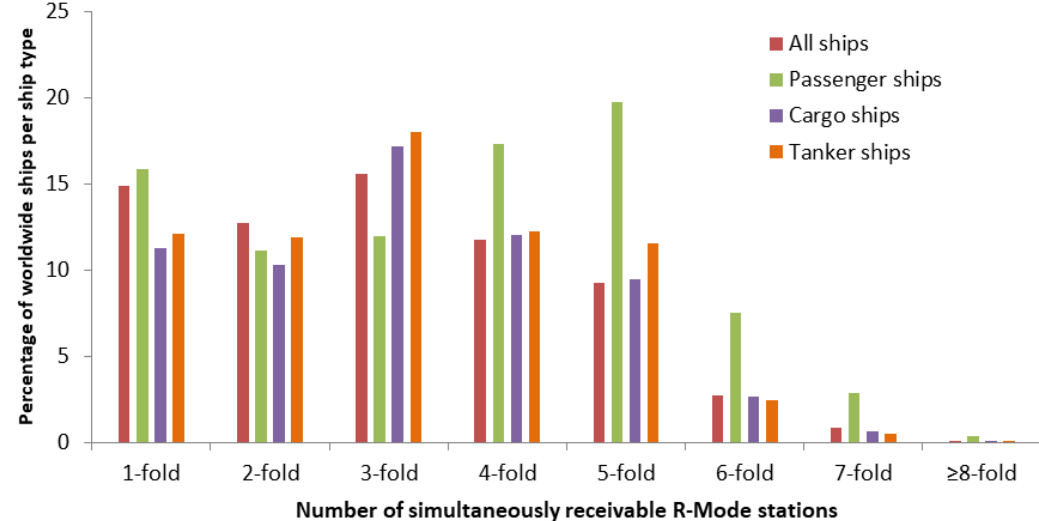
Figure 13. Comparison of R-Mode coverage and traffic density.